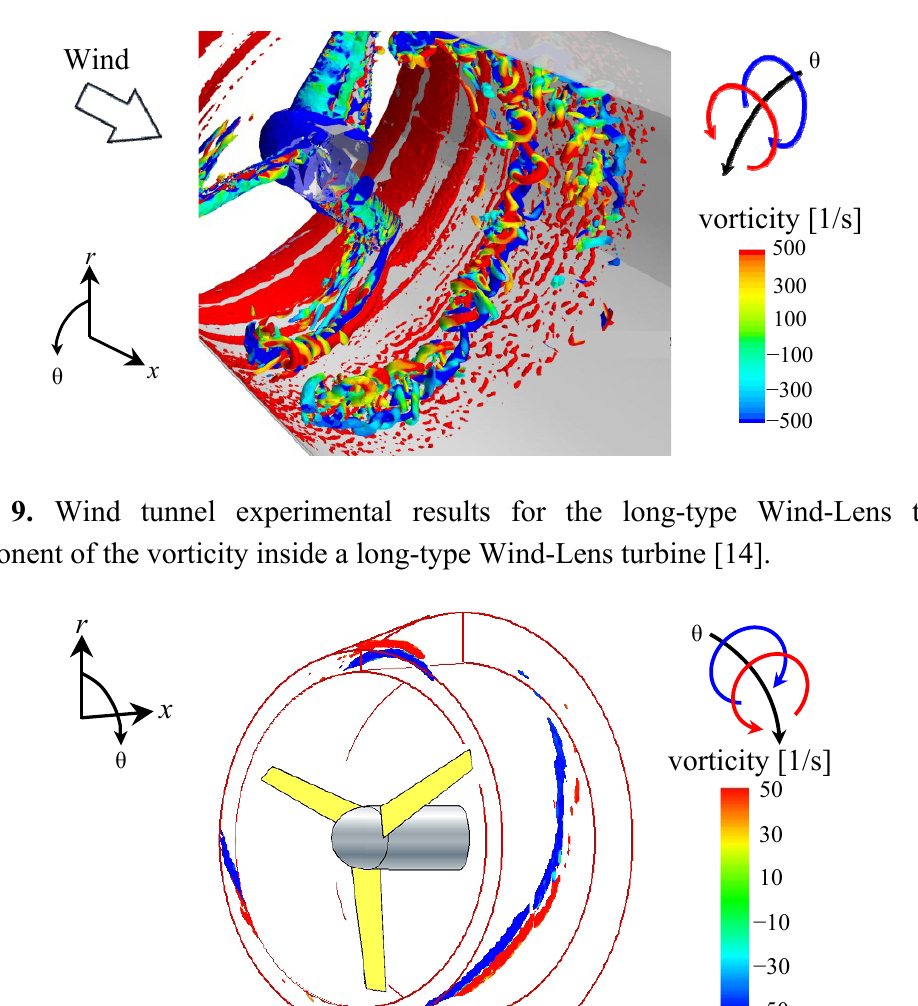
Figure 8. Simulation results for the long-type Wind-Lens turbine: θ -component of the vorticity inside a long-type Wind-Lens turbine. x : inflow direction; r : radial direction; θ : circumferential direction.